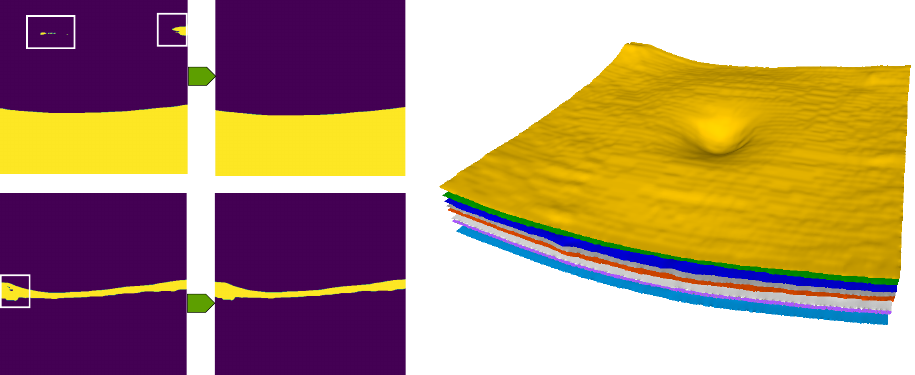
Figure 5. The first column shows small holes, which appear during the classification in both networks. The second column consists of images without holes. The last column shows 3D reconstructed surfaces of different